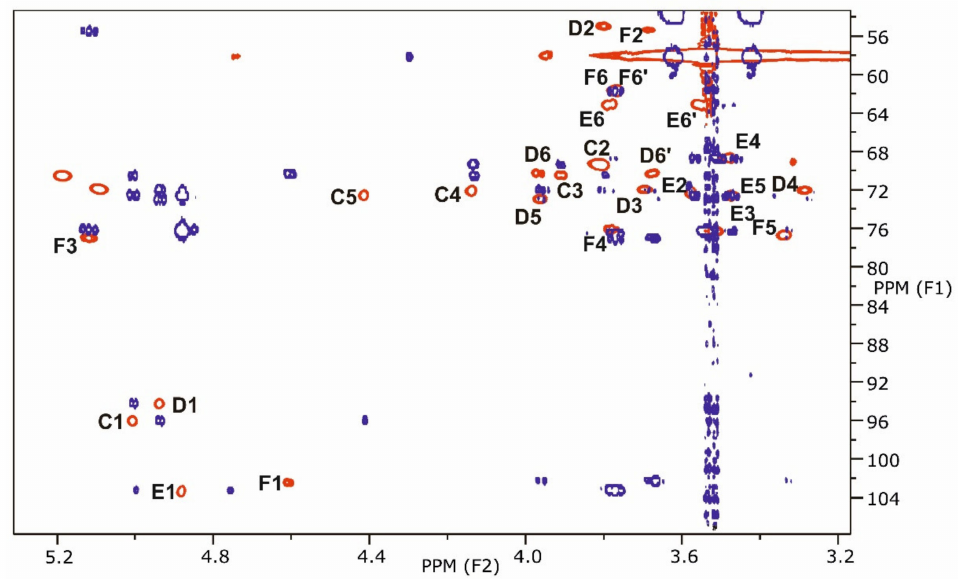
Figure 6. Part of the 1 H, 13 C HSQC (red) and 1 H, 13 C HMBC (dark blue) spectra of lipid A from Rv . Only HSQC signals from backbone sugar residues are marked. Table 3. 1 H and 13 C chemical shift data of the lipid A backbone tetrasaccharide α - D -Man p -(1 → 4)- β